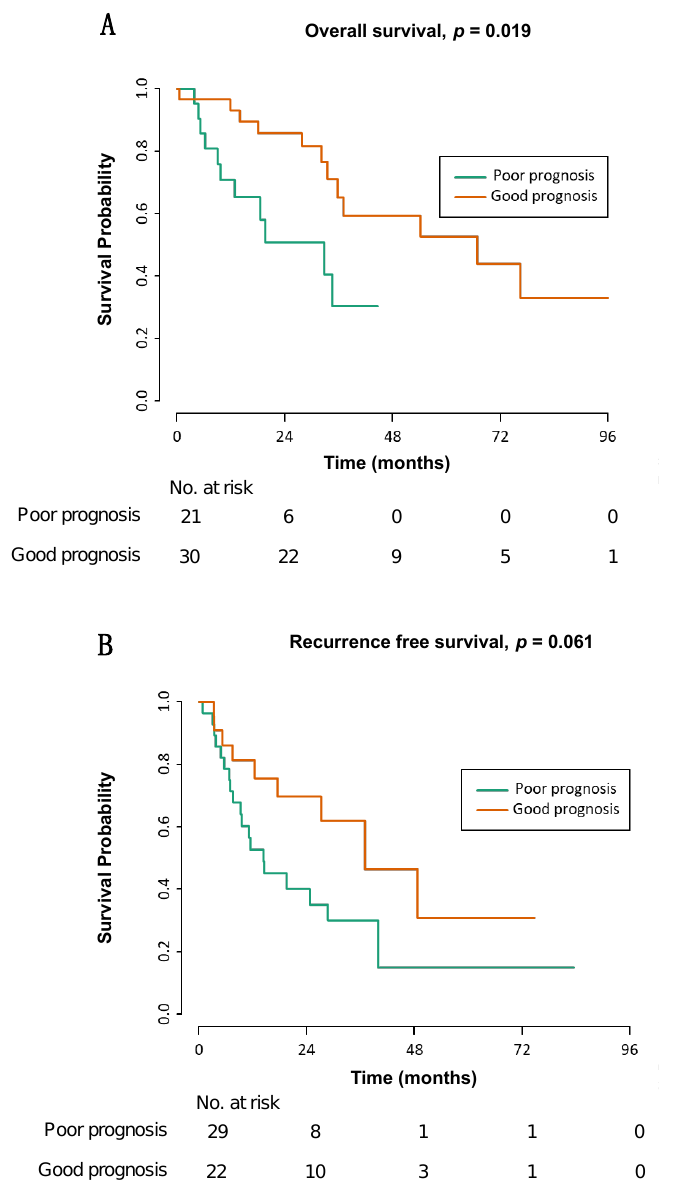
Figure 4. ( A ) Overall ( p = 0.019) and ( B ) recurrence-free survival ( p = 0.061) in retroperitoneal dedifferentiated liposarcoma (DDLS) as segregated by the five-gene prognostic signature.